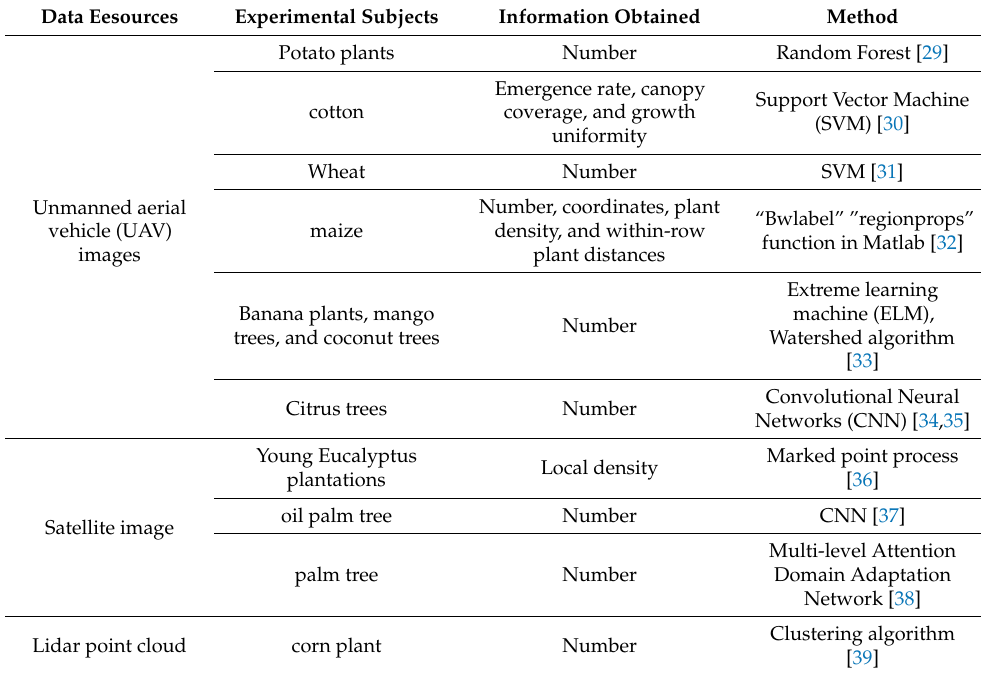
Table 1. Studies on seedling